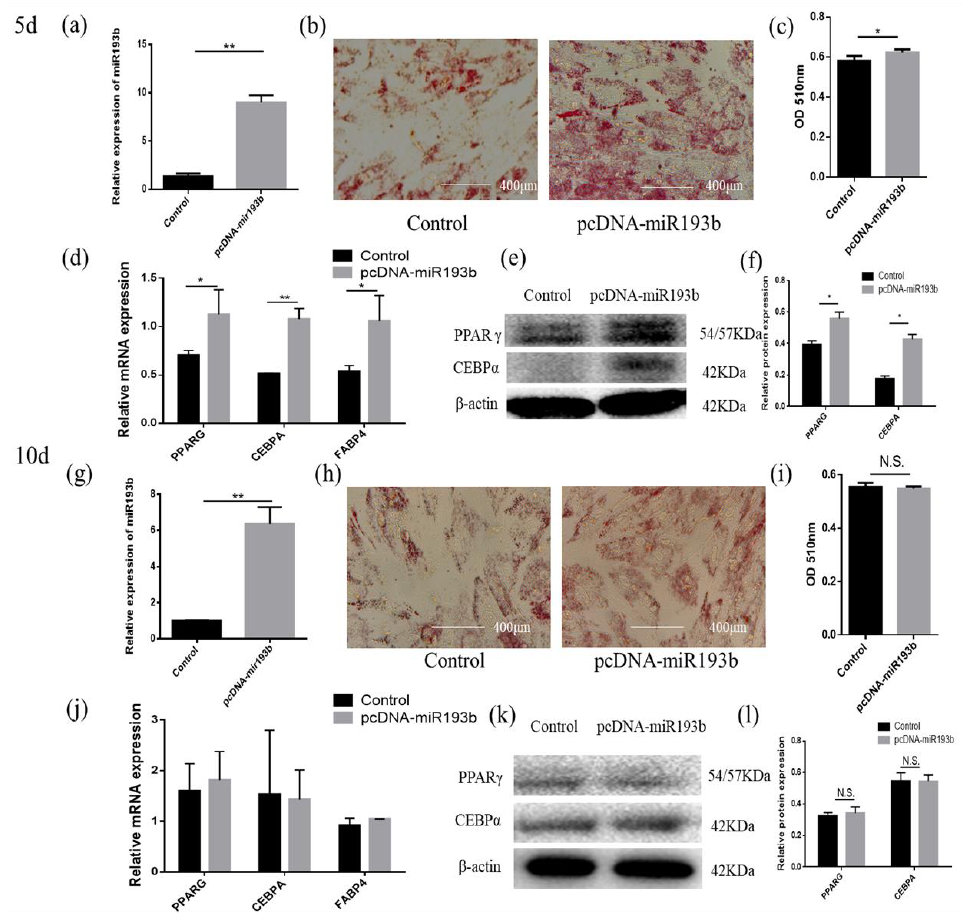
Figure 2. Bta-miR-193b promotes adipose cells ’ early differentiation. ( a , g ) Overexpression efficiency detection at day 5d or 10 d. ( b , h ) Oil Red O staining of adipose cells with bta-miR-193b at day 5d or 10 d. ( c , i ) The results quantified by microplate reader at 510 nm. ( d – f , j – l ) Overexpression of bta-miR-193b in adipose cells and continues induced to undergo differentiation for 5 or 10 days, and subsequent detection the mRNA expression of PPARG , C/EBPA and FABP4 by RT-qPCR compared with control group, and differentiation of adipose cells detected by western blot. The expression of miRNAs was normalized to U6. Values are mean ± SD for three biological replicates, * p < 0.05, ** p < 0.01.